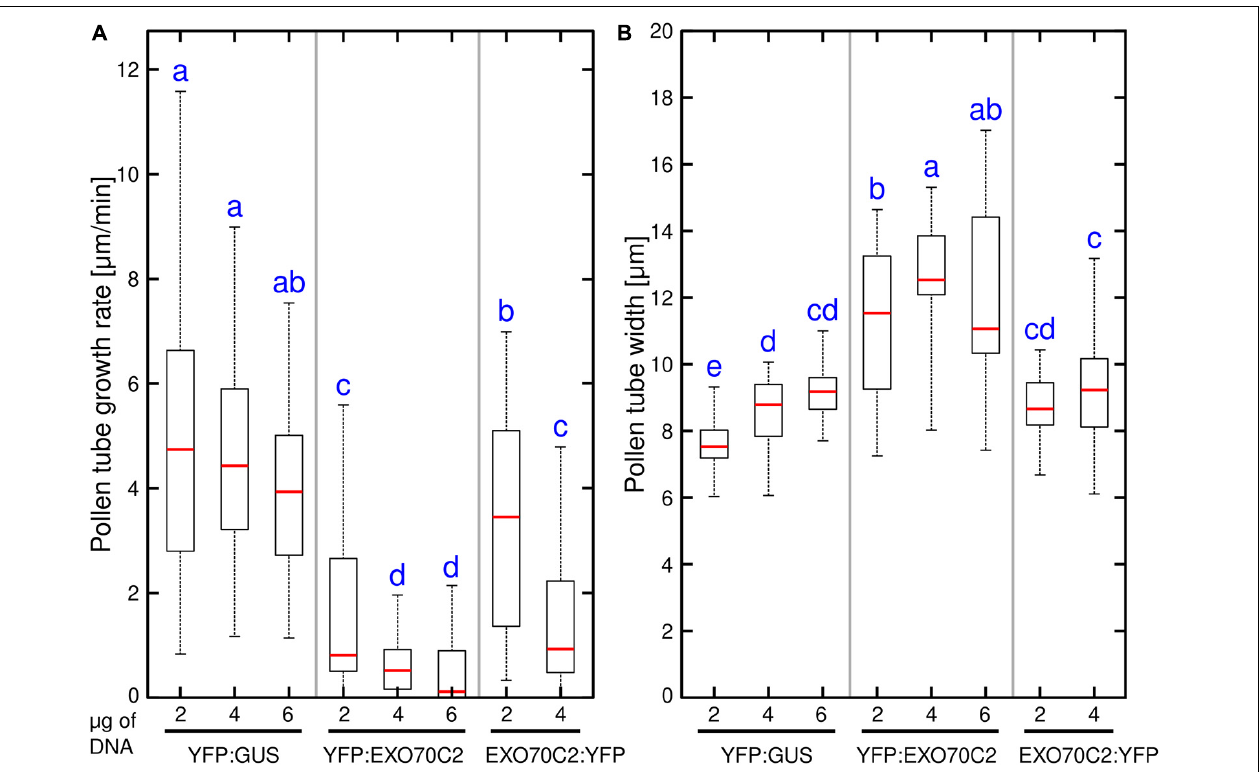
FIGURE 3 | Expression of Arabidopsis EXO70C2 in tobacco pollen tubes alters pollen tube growth rate (A) and thickness (B) in dose-dependent manner. Three different DNA amounts (2, 4, and 6 µ g) of constructs coding for wild type YFP:AtEXO70C2 or AtEXO70C2:YFP were transiently expressed in Nicotiana tabacum pollen tubes. Pollen tubes expressing YFP:GUS were used as a control. Measurements were performed on at least 40 transformed growing cells per each construct imaged in three independent experiments. Different letters indicate significant differences between samples at P <